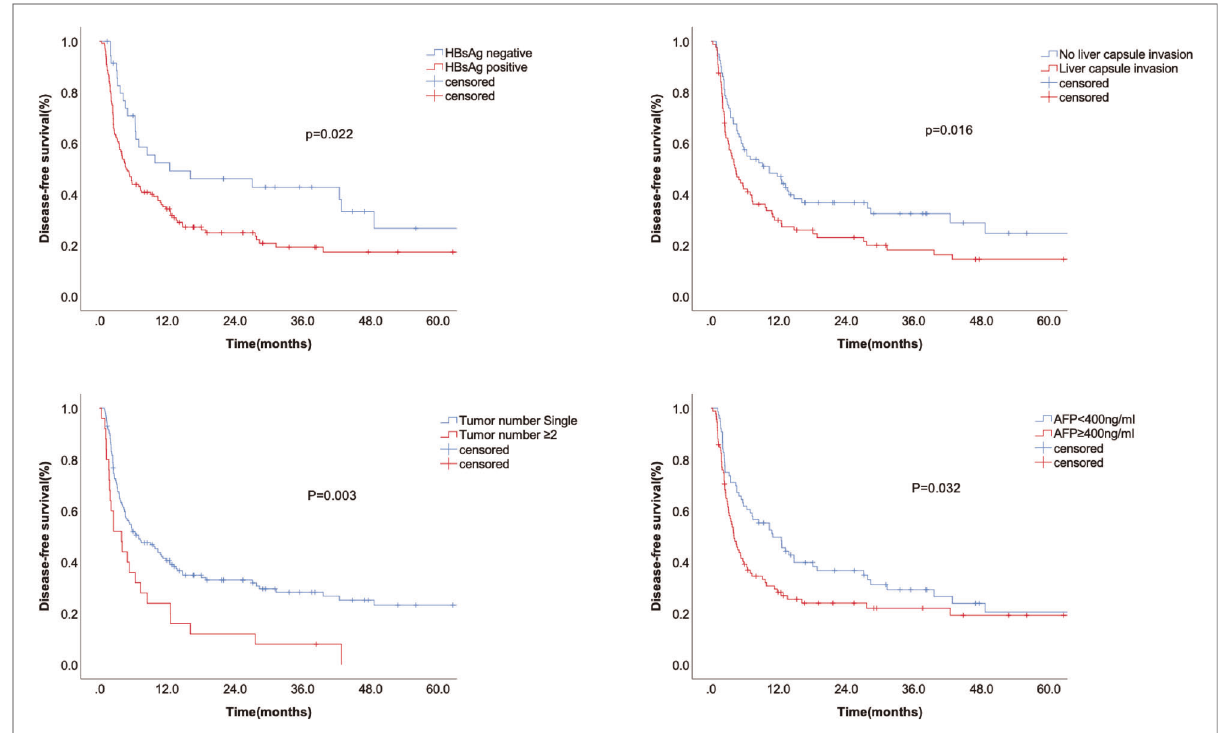
FIGURE 2 The disease-free survival according to HBsAg, liver capsule invasion, AFP level, and tumor number.